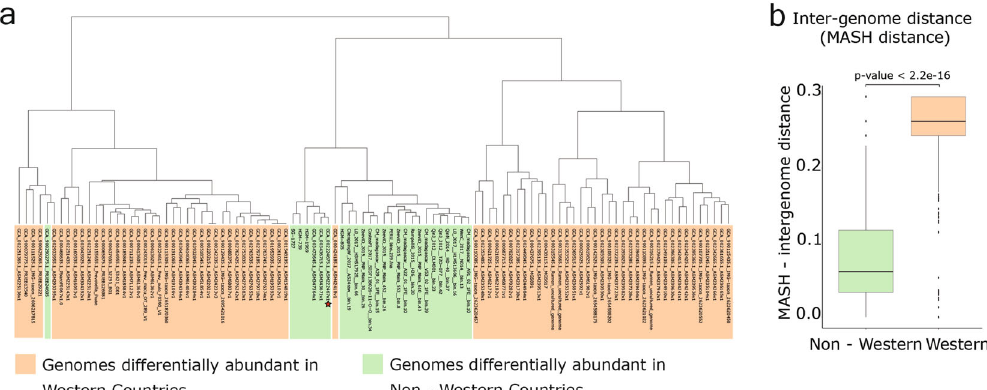
Fig. 3 Signi fi cantly lower intergenomic distance of differentially abundant Prevotella genomes in non-western populations. a Cladogram constructed based on the intergenome distance (MASH-distance) between genomes/bins differentially abundant in non-western and western populations. Text highlighted in a lighter shade of green color are differentially abundant Prevotella genomes in non-western populations, and the text highlighted in orange color are differentially abundant Prevotella genomes in western population. The Prevotella genome highlighted using red-colored star is of P. copri (Assembly accession: GCA_002224675.1). b Box plots show the intergenome distance of differentially abundant Prevotella genomes in non-western and western populations. The pair of entries that showed intergenome distance = 1 were excluded from this plot. The whiskers, bound of the box, and the line in the middle of the box represent the min-to-max values, 25th – 75th percentiles, and median, respectively. Signi fi cance levels were evaluated using Wilcoxon rank-sum